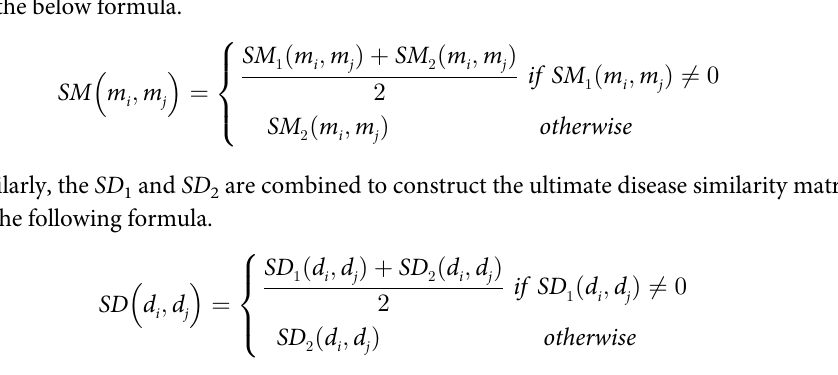
PLOS Computational Biology | https://doi.org/10.1371/journal.pcbi.1009655 December 10,